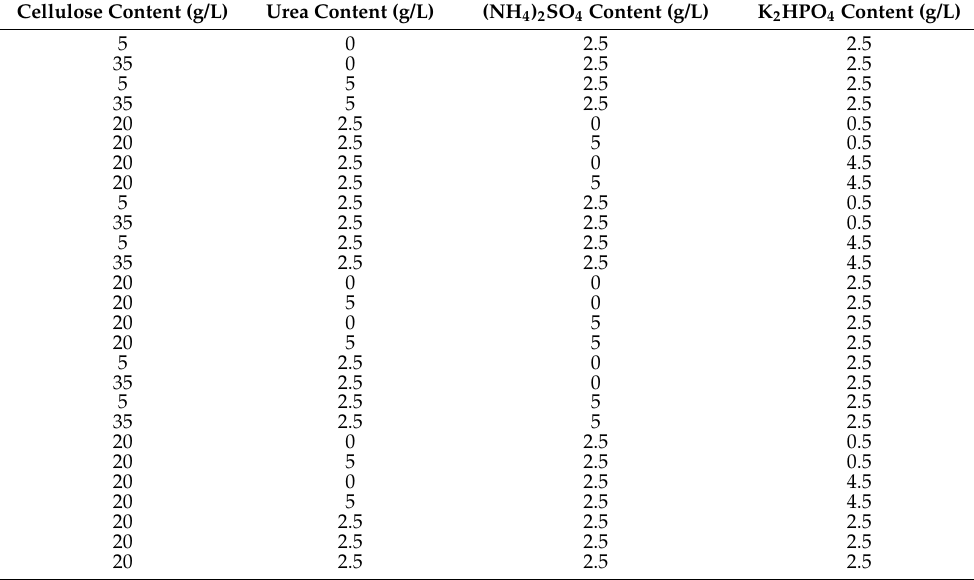
Table A1. Box-Behnken experimental design = varied values of independent